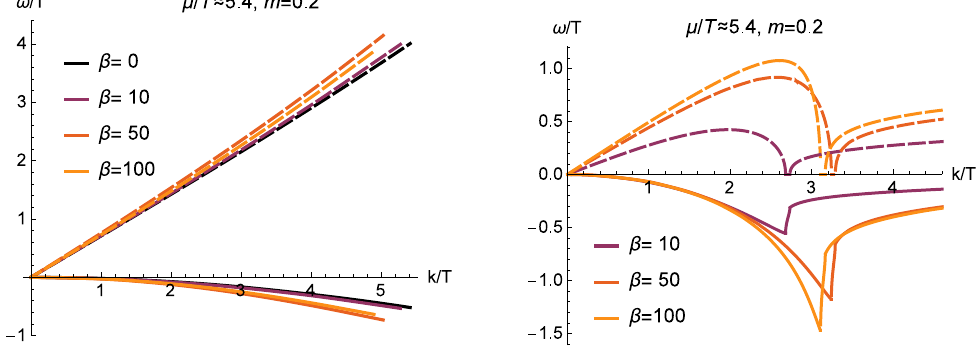
Figure 12 . The linear QNM (left) and ‘cloud’ CM (right) at (cid:22)=T (cid:25) 5 : 4, m = 0 : 2. Note the formation of an overdamped ‘exotic’ region in the